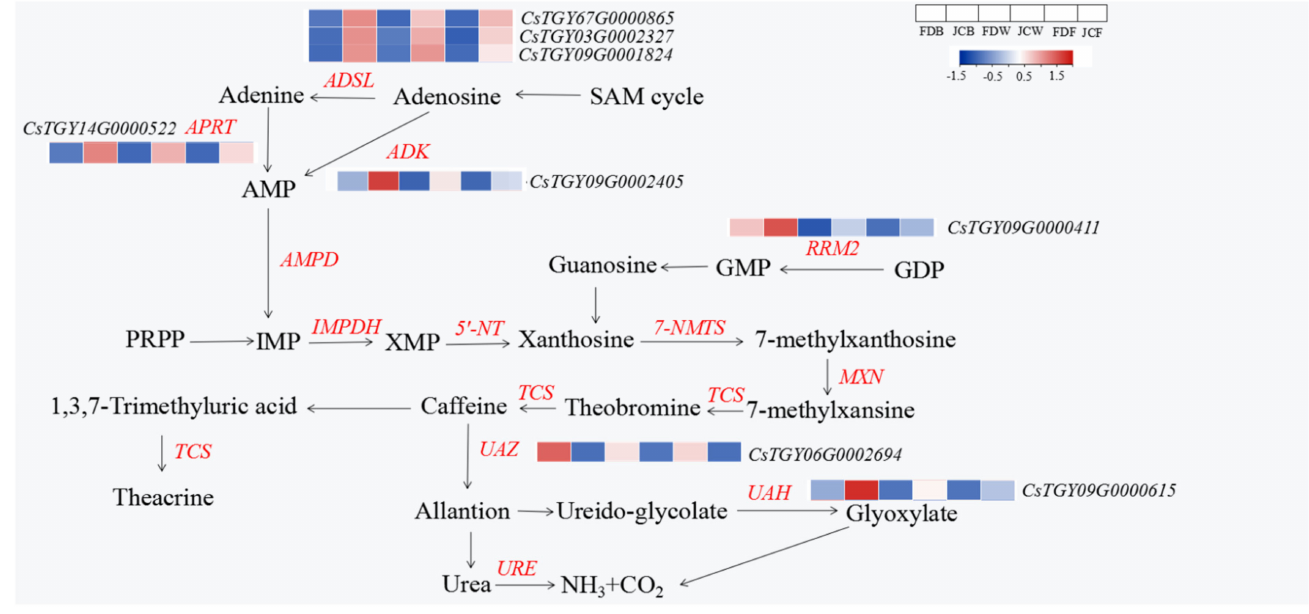
Figure 7. Heatmap of common DEGs in three